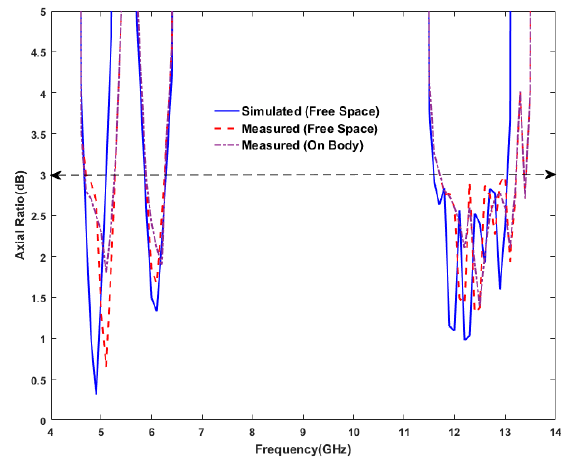
Figure 10. Axial ratio performance of the proposed antenna.